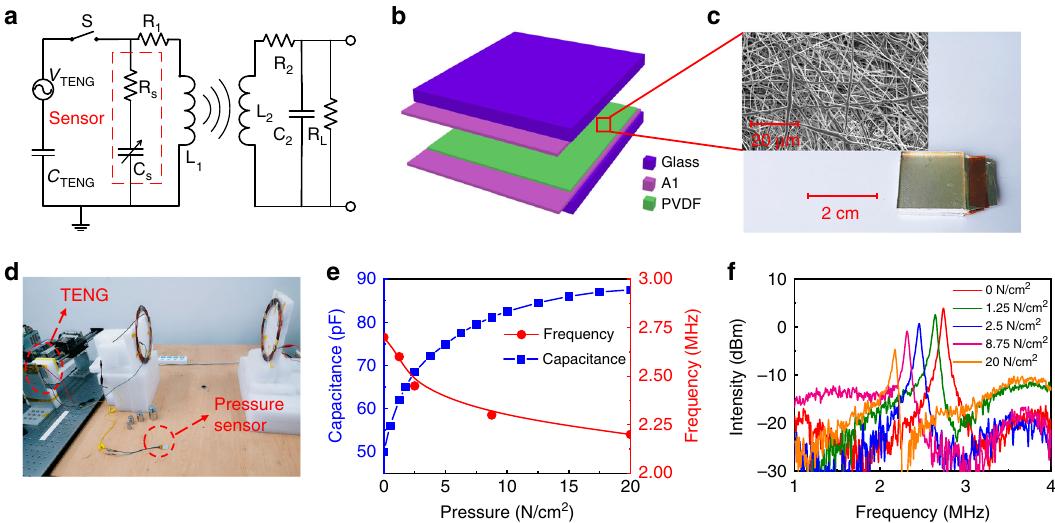
Fig. 6 MR-WTENG-based wireless chipless sensor. a The con fi guration of the wireless chipless sensor system with the sensor integrated in the resonant circuit. b , c are the structure and photo of the electrospun PVDF nano fi ber membrane-based capacitive-type force sensor. d The photo of the wireless sensing system. e The capacitance variation with different pressures applied to the sensor. f The FFT spectra received by the remote receiver at 2 m as a function of pressure applied on the sensor. The diameter of the two coils is 21.5/27cm for this experiment, C 2 = 82 pF and R L = 3.3 k Ω